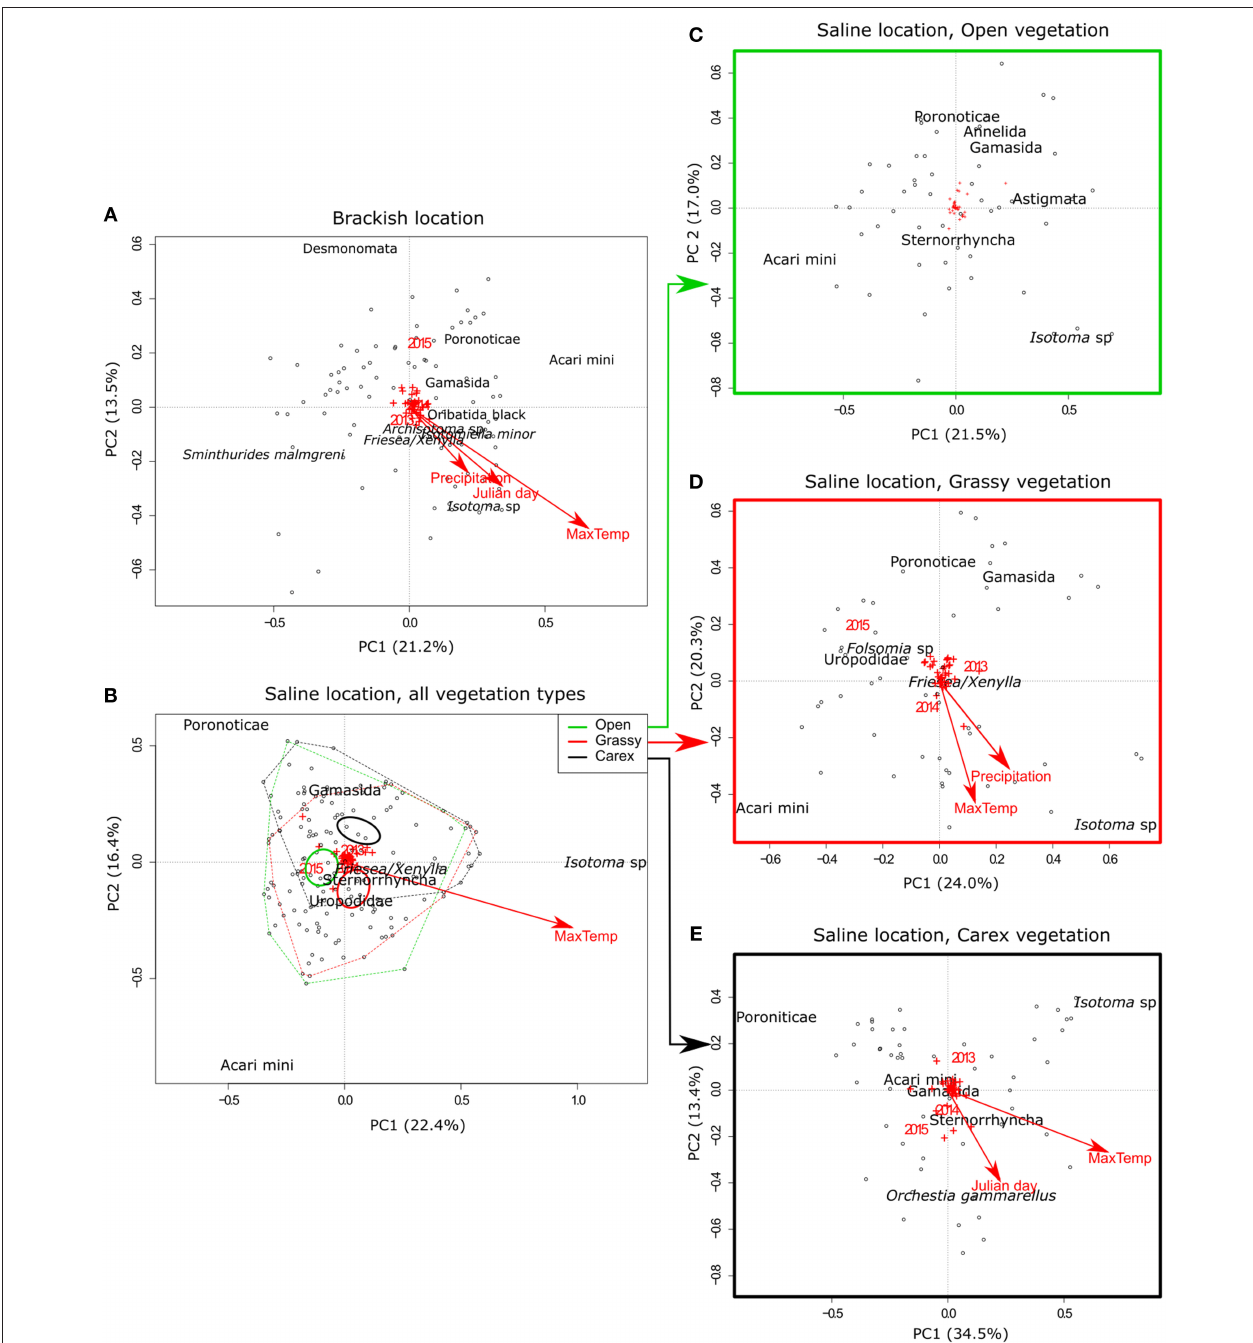
FIGURE 2 | PCA axes 1 and 2 for the (A) brackish location, (B) saline location, with polygons drawn through all the outer sample points of the three vegetation types and the inner thick circle indicating the 95% confidence interval of the centroids for these locations, (C–E) subsets of the saline location, with (C) samples from open vegetation, (D) grassy vegetation, and (E) Carex vegetation. Black dots depict the samples in each plot. Taxa with an abundance of more than 2.5% per location or vegetation type are plotted textually (the exact location is the center of the text), the other taxa are visualized as red plusses. The environmental factors that significantly correlate with the samples are indicated by a red arrow for continuous variables or red names for factors with multiple